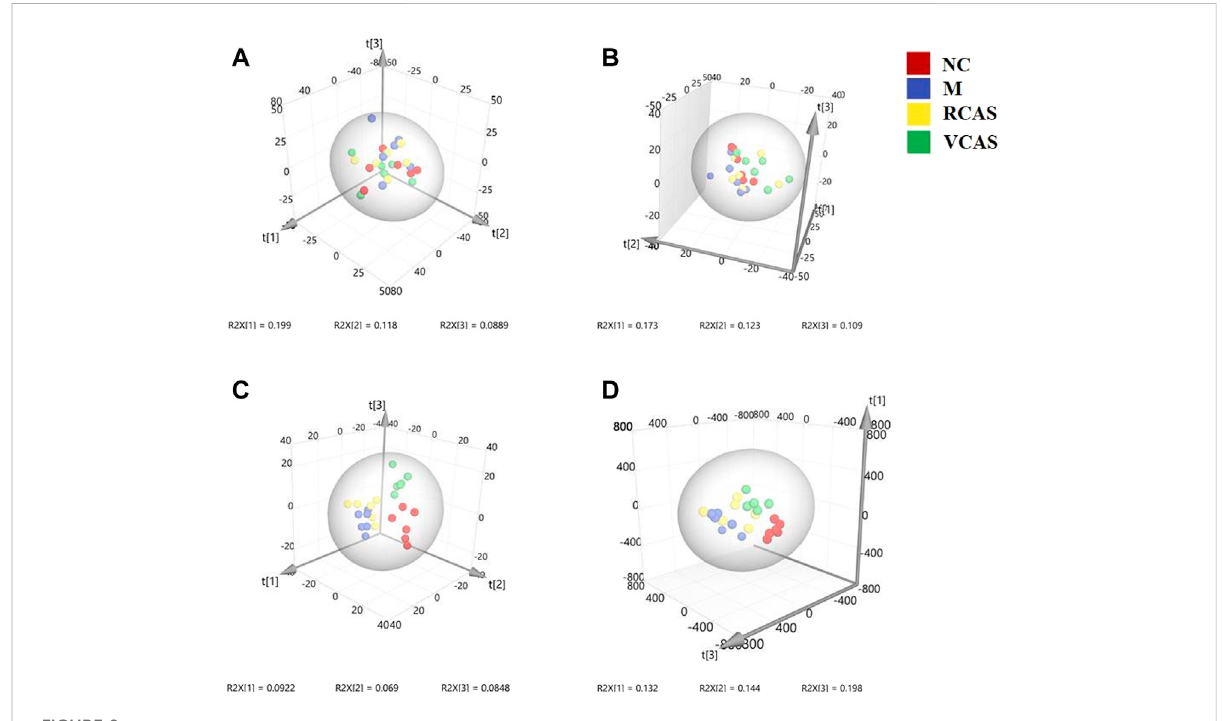
FIGURE 9 PCAandPLS-DA3D-scorescatterplotofUPLC-Q-TOF/MSdatafromfecessamples. (A) PCA3D-scorescatterplotinthepositiveionmode; (B) PCA 3D-score scatter plot in the negative ion mode; (C) PLS-DA 3D-score scatter lot in the positive ion mode; (D) PLS-DA 3D-score scatter plot in the negative ion